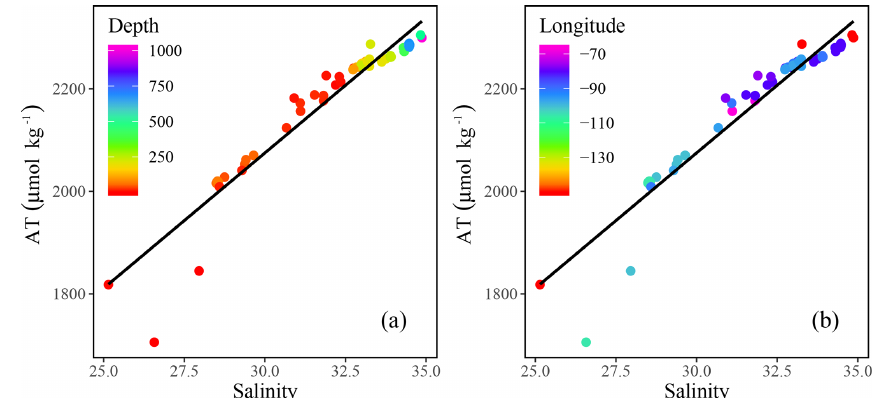
Figure 4. Total alkalinity (AT) vs. salinity ( S P ) measured throughout the CAA with the colors indicating (a) depth and (b) longitude. A linear regression analysis yields AT = 52 . 7 × S P + 492 . 3 ( R 2 = 0 . 91).